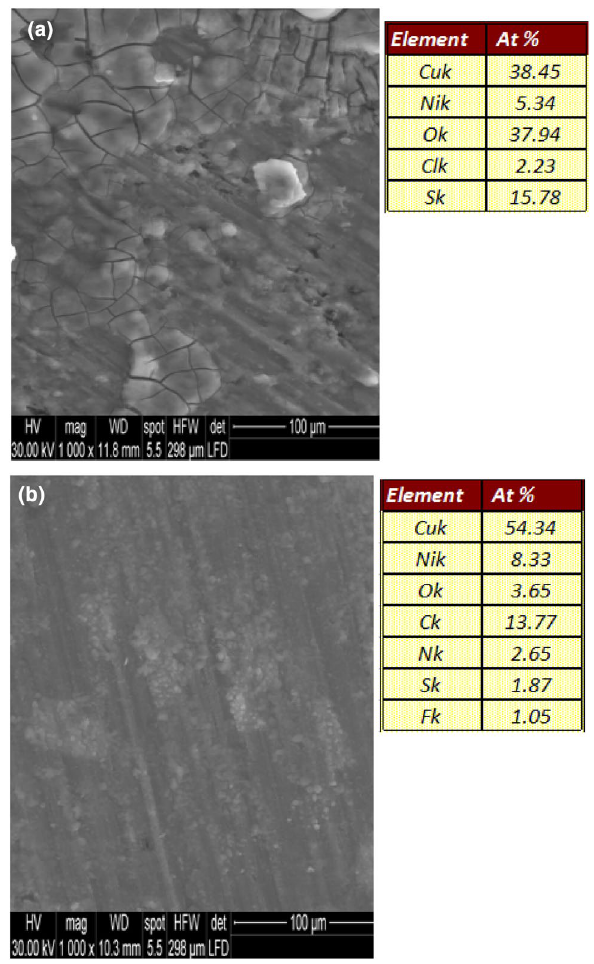
Figure 4. SEM and EDX images of the Cu–Ni alloy after 48 h immersion in ( a ) 3.5% NaCl + 10 ppm sulfide solution, ( b ) in 3.5% NaCl + 10 ppm sulfide + 120 ppm [DEMEMA][FSI] solution at 298 K.